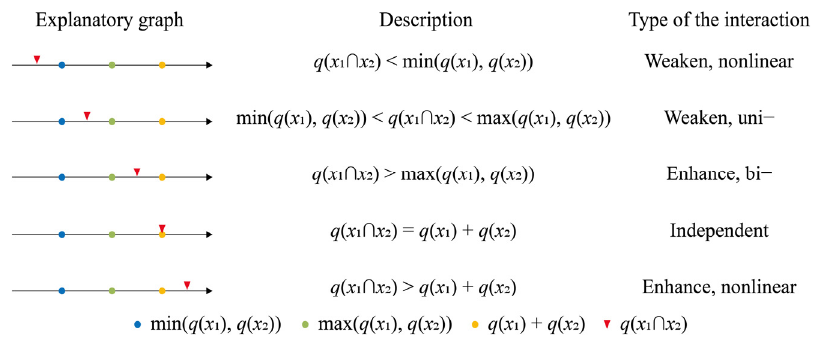
Figure 3. Types of